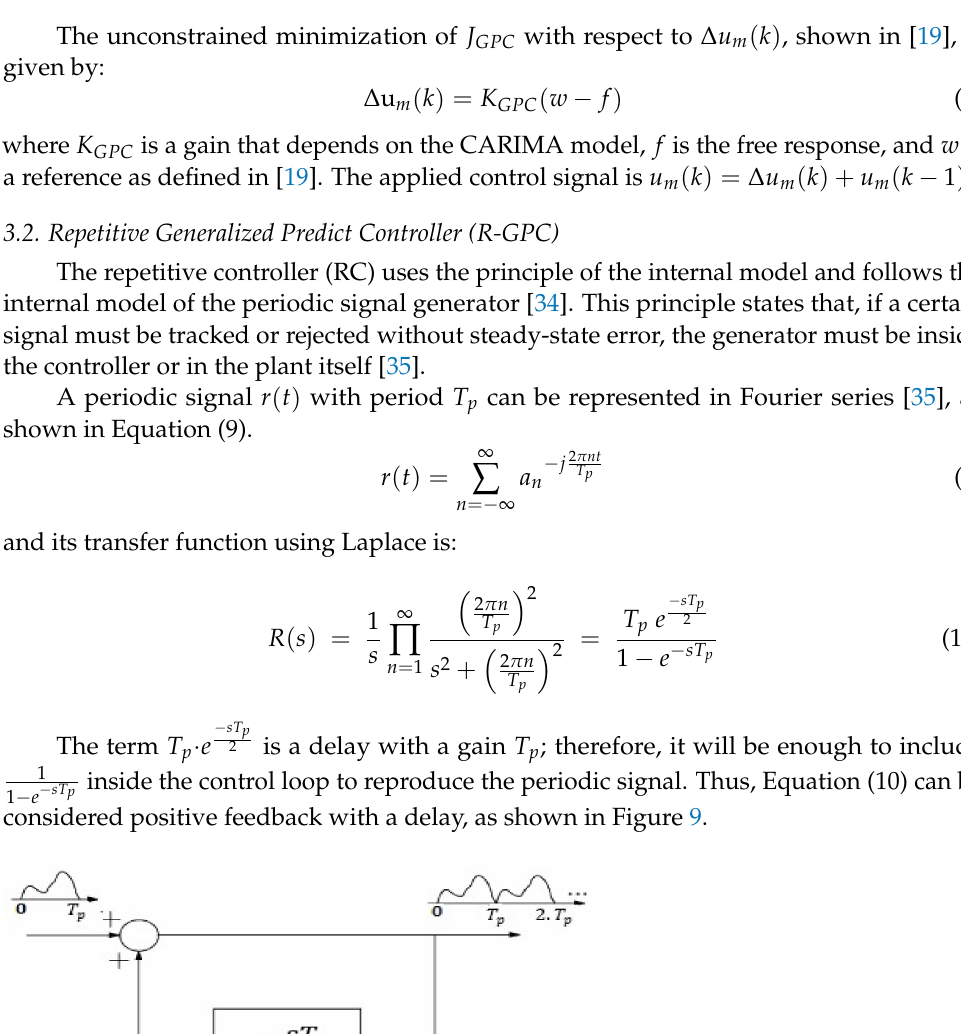
Figure 8. Incremental model in series with the process.